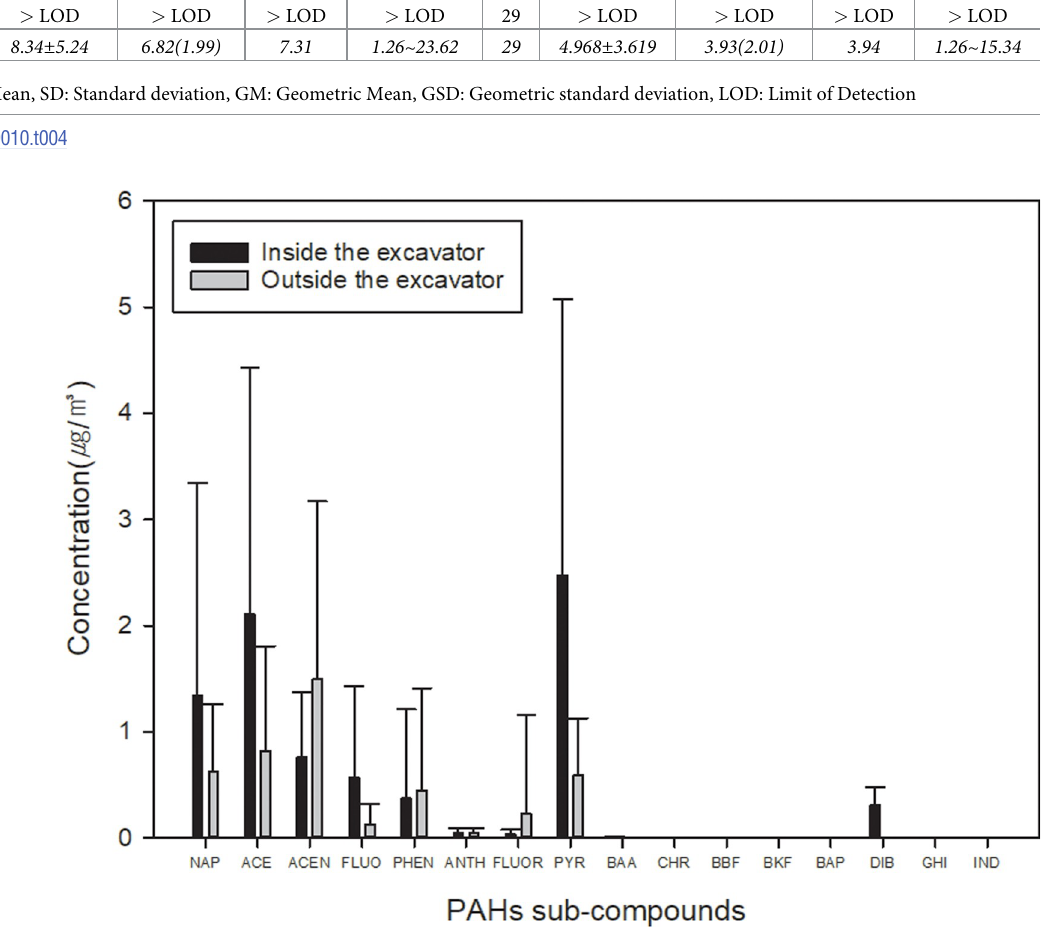
Fig 3. Mean concentration of PAHs sub-compounds, along with standard deviation (error bar), from inside and outside the excavator in underground excavation site. NAP: Naphthalene, ACE: Acenaphthylene, ACEN: Acenaphthene, FLUO: Fluorene, PHEN: Phenanthrene, ANTH: Anthracene, FLOUR: Fluoranthene, PYR: Pyrene, BAA: Benz(a) anthracene, CHR: Chrysene, BBF: Benzo(b)fluoanthene, BAP: Benzo(a)pyrene, DIB: Dibenz(a,h)anthracene, IND: Indeno